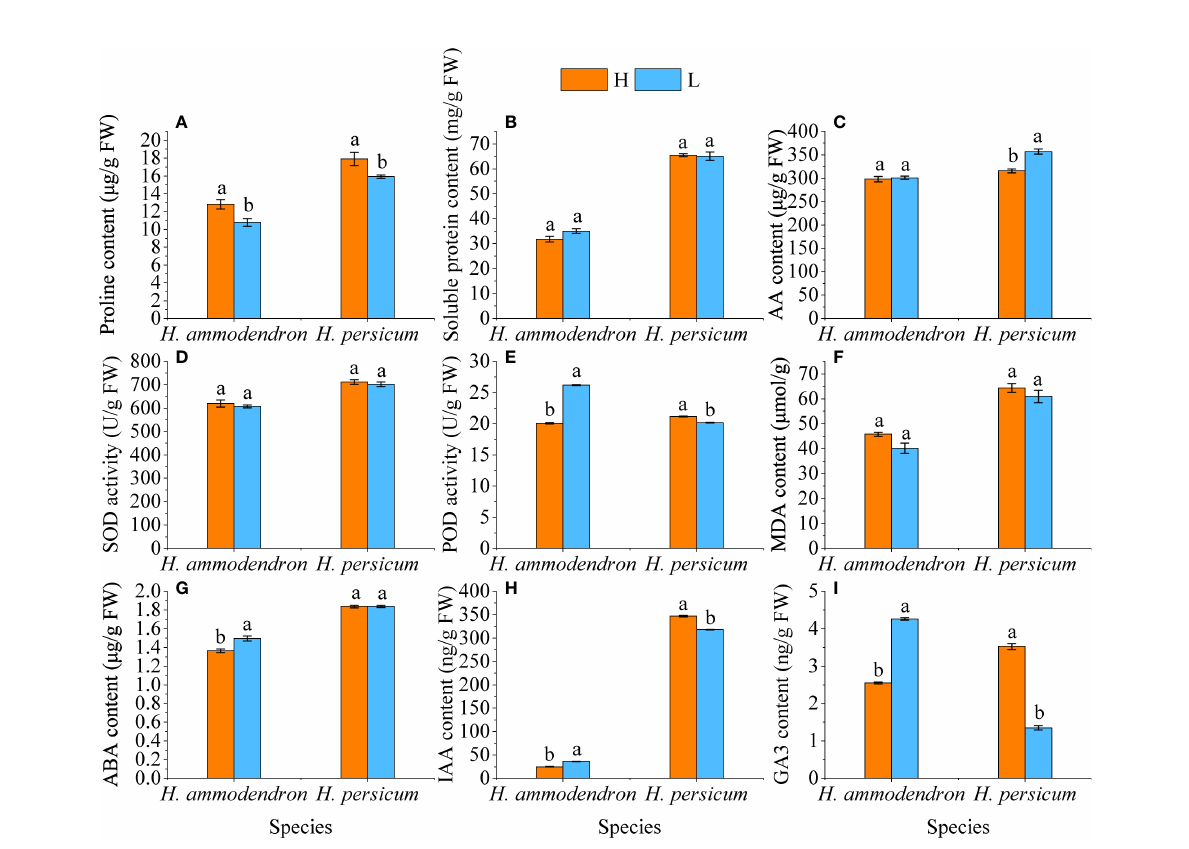
FIGURE 3 Effects of drought stress on the physiological changes in H. ammodendron and H. persicum . (A) Pro content; (B) Soluble protein content; (C) AA content; (D) SOD activity; (E) POD content; (F) MDA content; (G) ABA content; (H) IAA content; (I) GA3 content. Different letters indicate signi fi cant differences at P < 0.05. The values shown are the means of three biological replicates ± SE ( n = 3). H: Wet environment; L: Dry